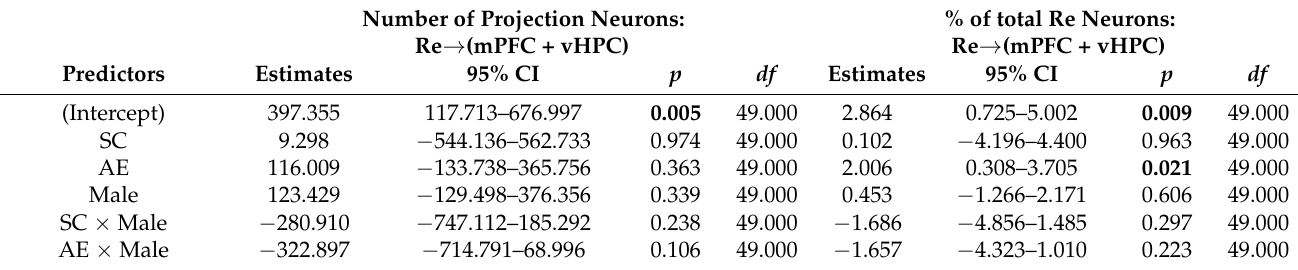
Figure 4. Quantification of Re projection neurons that simultaneously innervate mPFC and/or vHPC. ( a – c ) Total number of Re projection neurons (left of each panel) and the proportion of total Re neurons comprised of this class of projection neuron (right of each panel) that innervated mPFC and vHPC concurrently ( a ), mPFC alone ( b ), or vHPC alone ( c ). While the total number of each class of projection neuron was not influenced by postnatal treatment, the proportion of Re → (mPFC + vHPC) neurons (relative to total neurons in Re) was significantly increased in the AE treatment group. For all panels in this figure, individual data points represent one animal and are superimposed over bars representing mean within that postnatal treatment. Data include both male and female animals, which are not differentiated due to the lack of sex effects. Sample sizes are given in parentheses below each treatment group. * p ≤ 0.050. For exact statistical values, see Tables 4–6 (and Tables S6–S8 for injection parameter-controlled values). Table 4. Regression table for Re → (mPFC + vHPC) projection neurons, as visualized in Figure 2 and quantified in Figure 4. Table was generated using the “tab_model” function (df method = Satterthwaite) from the “sjPlot” package on “lmer” objects from the “lmerTest” package. Similar table controlling for injection properties (diffusion of AAVrg-CAG at the injection sites (fixed effects), the amount of incubation time following AAV injection (fixed effect), and the fluorophore-site pairing (random effect)) can be found in the Supplementary Material (Section S.2.3). Significant predictors (i.e., p ≤ 0.050) are indicated by bold p